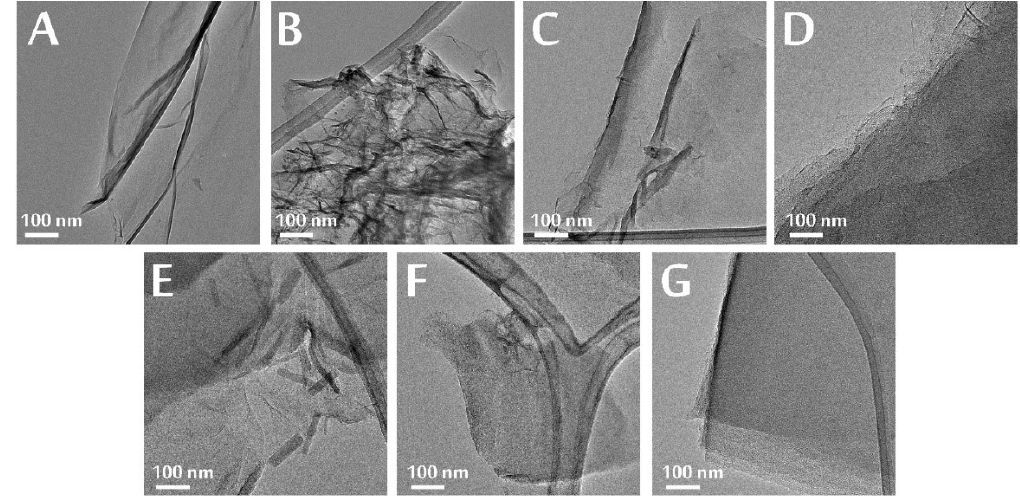
Figure 4. TEM images of the GO ( A ), GO AA ( B ), GO-air 200°C ( C ), GO-air 300°C ( D ), GO-N2 200°C ( E ), GO-N2 300°C ( F ) and GO-N2 900°C ( G ).